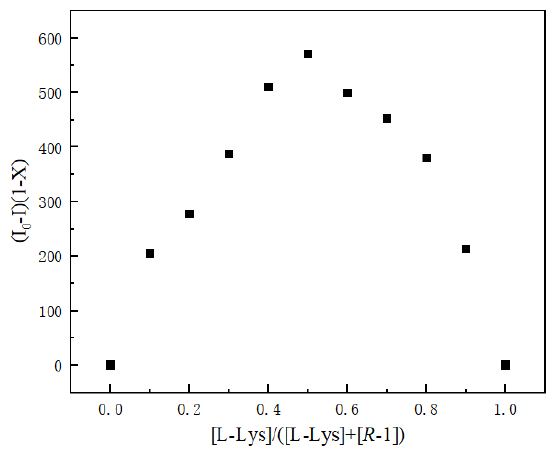
Figure 5. Determination of the complexation ratio of probe R - 1 to L -Lys.